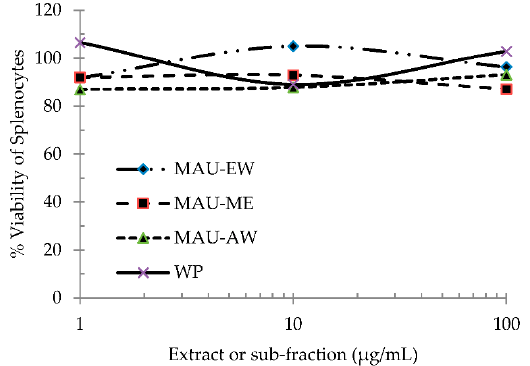
Figure 3. Cytotoxicity of WP, MAU-EW, MAU-ME and MAU-AW on mouse splenocytes. The MultiTox assay was performed following 48 h of incubation of several concentrations of each fraction with mouse spleen cells. At the end of incubation, live cell and dead cell substrates were added to all wells, mixed briefly on an orbital shaker and incubated for 30 min at 37 ˝ C. The fluorescence was measured by the GloMax ® -Multi Detection System for viability (excitation 495 nm; emission 505 nm), and (cytotoxicity: excitation 510 nm; emission 570 nm). Data represent the average of six replicates ( ˘ SEM) of the fluorescence signals of the alive/dead signals of each well. No reduction in % viability of spleen cells was observed.